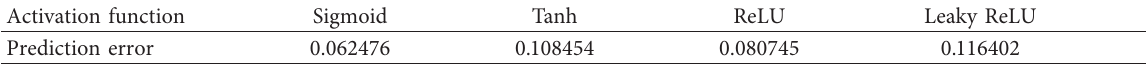
Table 4: Experimental prediction error of different activation functions.